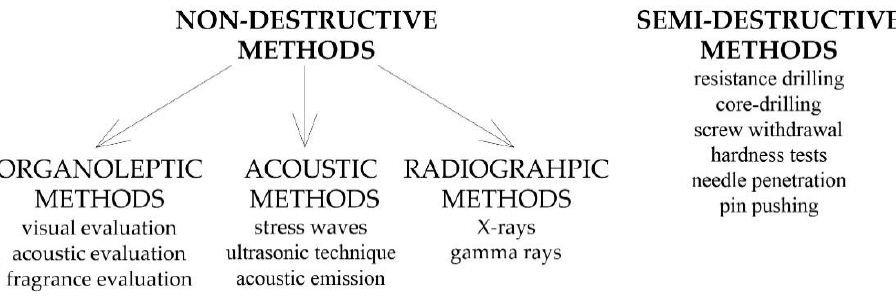
Figure 1. Non-destructive and semi-destructive testing methods.